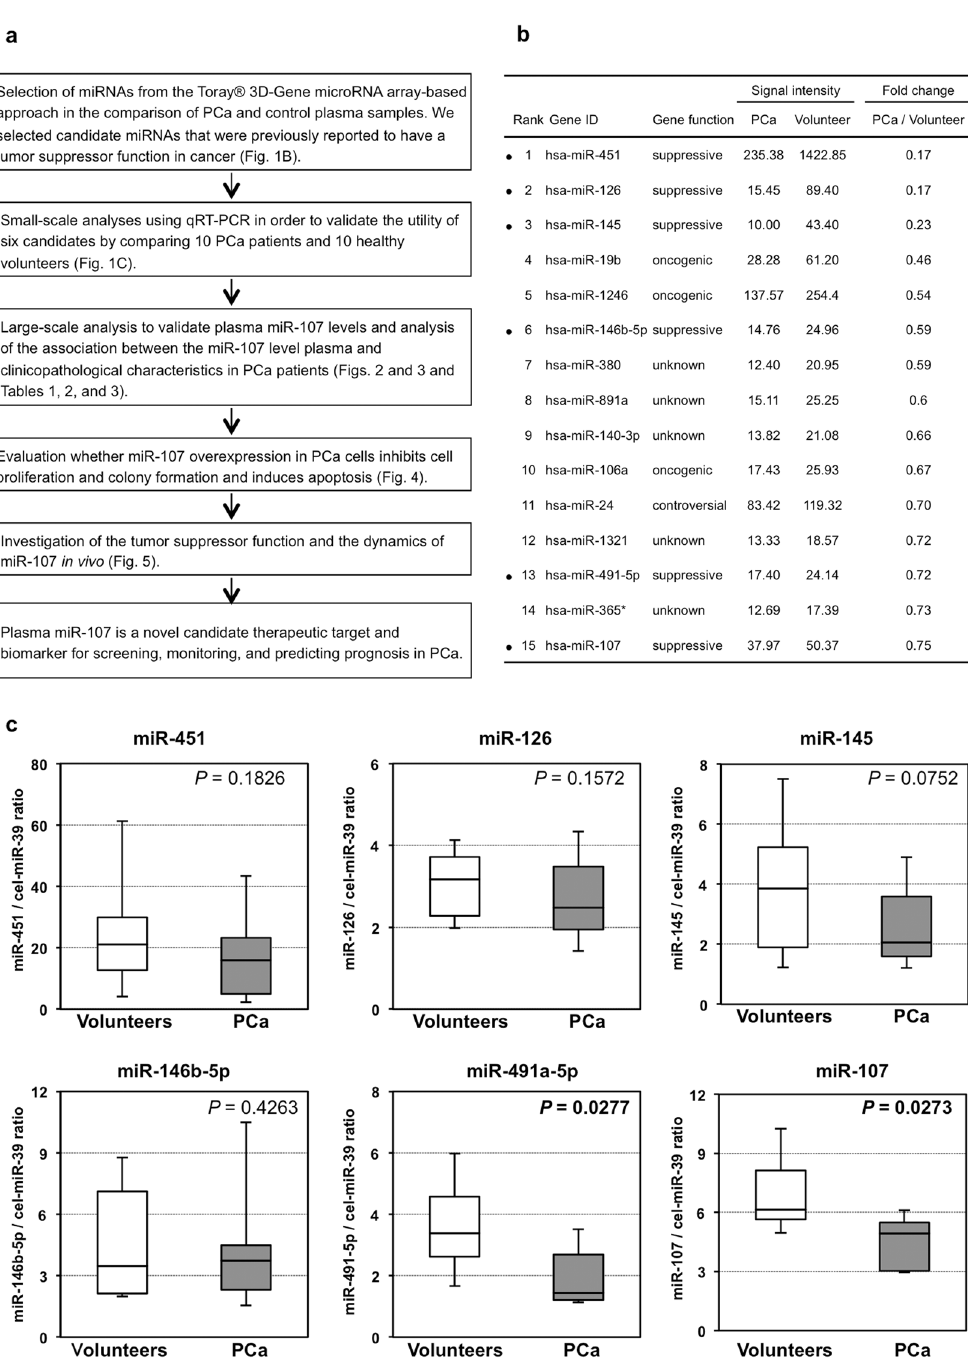
and to detect the optimal cut-off points that could differentiate cancer patients from healthy volunteers, we per- formed a receiver operating characteristic (ROC) analysis (Fig. 2b). The ROC curve was created by plotting the sensitivity against the false positive rate (1- specificity) at various threshold settings. We utilized the AUC value